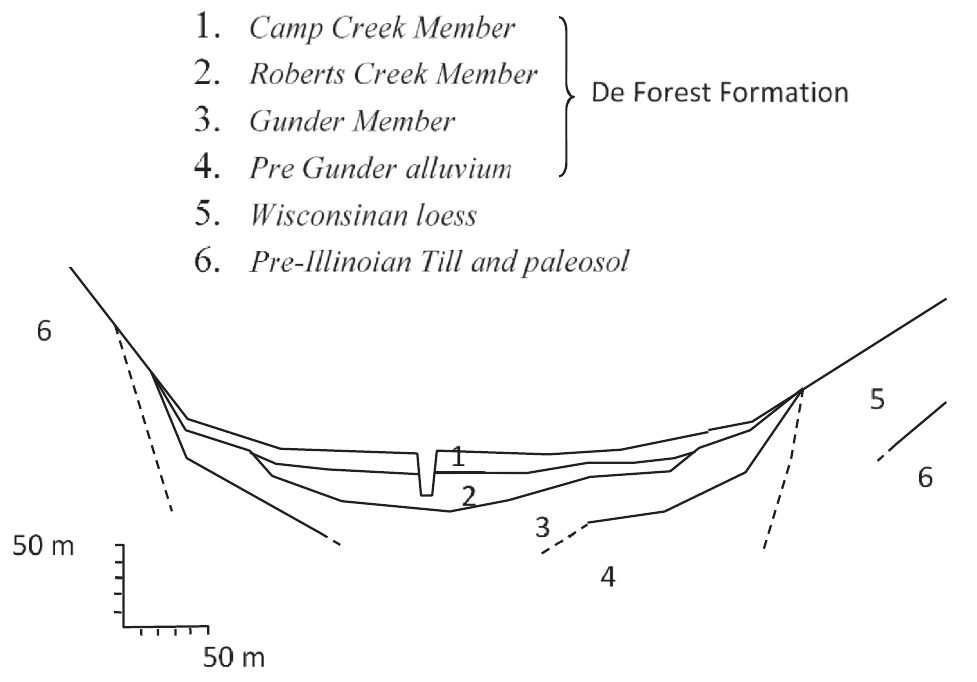
Fig 1. A schematic alluvial cross section through alluvium in the Walnut Creek watershed, adapted from Schilling et al. [20]. In some locations, the channel is close enough to the valley wall that the stream contacts Pre-Illinoian Till.